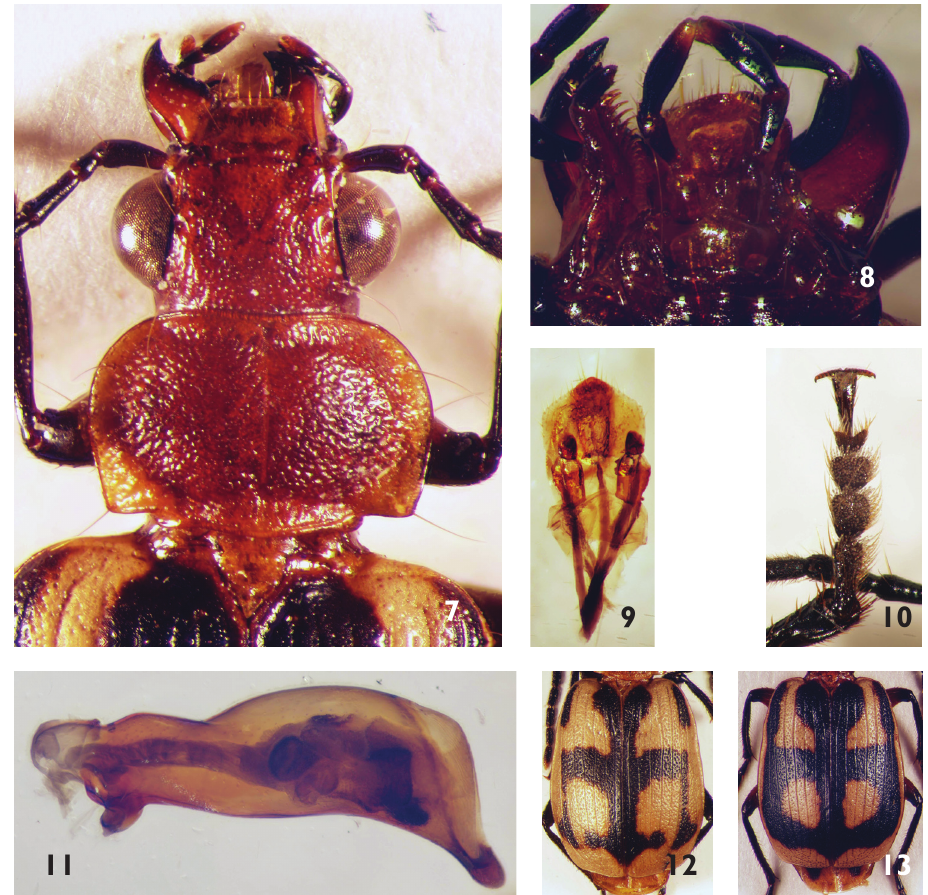
Figure 7–13. Lebistina petersae sp. n. 7 head and pronotum (female) 8 head, lower side (female) 9 ligula and paraglossae (female) 10 protarsus, lower side (male) 11 median lobe of aedeagus 12 elytra with re- duced dark pattern (female) 13 elytra with large dark pattern